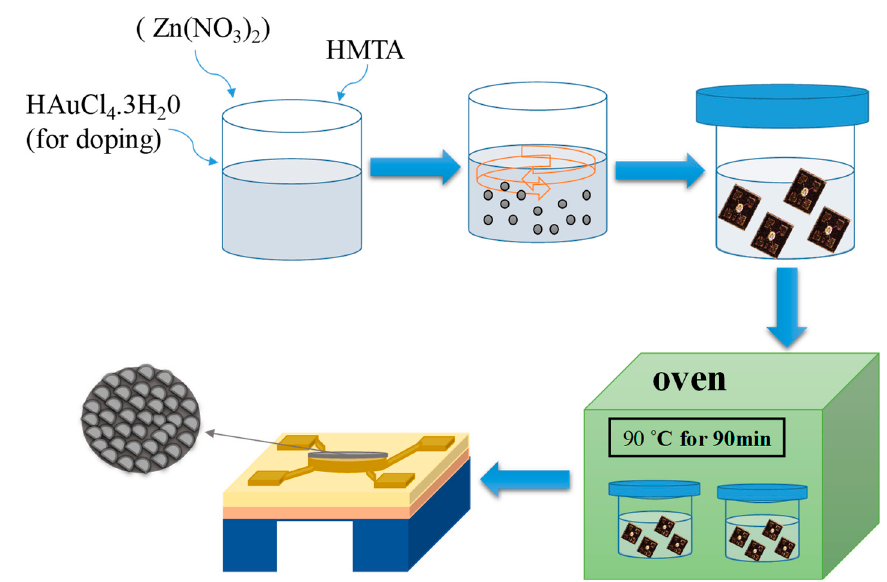
Figure 1. Hydrothermal process of ZnO nanosheet deposition.